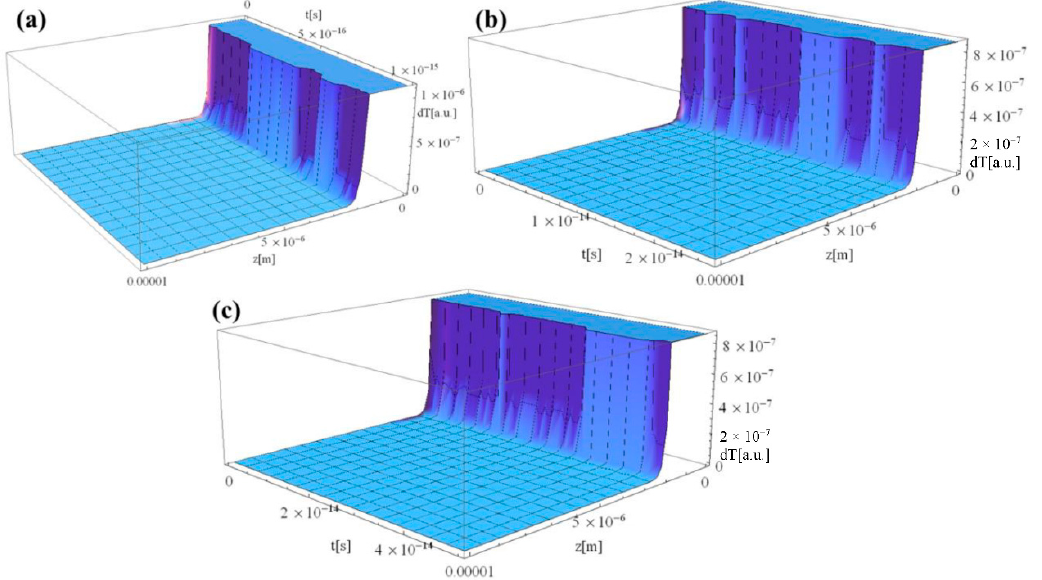
Figure 3. Laser–Al interaction for different durations of the laser pulse: ( a ) 1, ( b ) 10, and ( c ) 100 as.